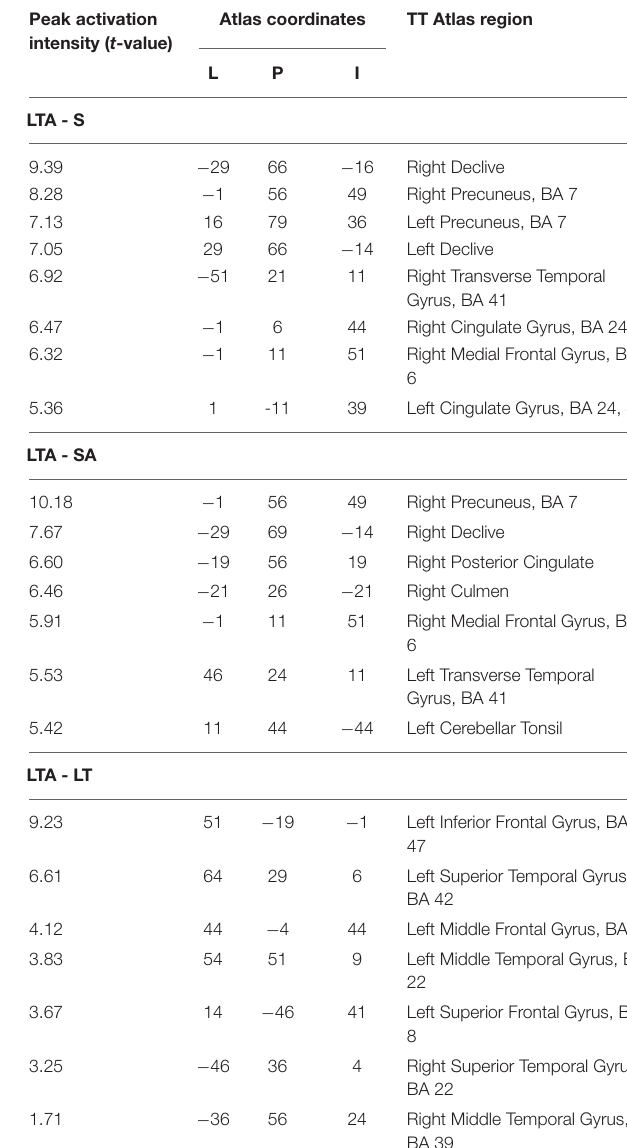
BA, Brodmann Area; S, straight driving; SA, straight driving with auditory distraction; L, left turns; R, right turns; LT, left turns with oncoming traffic; LTA, left turns with oncoming traffic and auditory distraction. Atlas coordinates L, left; P, posterior; I, inferior. Not all regions of significant activation are reported, with a cutoff value of t = 5 (unless there were less than 3 regions greater than this cutoff). Each peak within a given activation zone is only reported once.